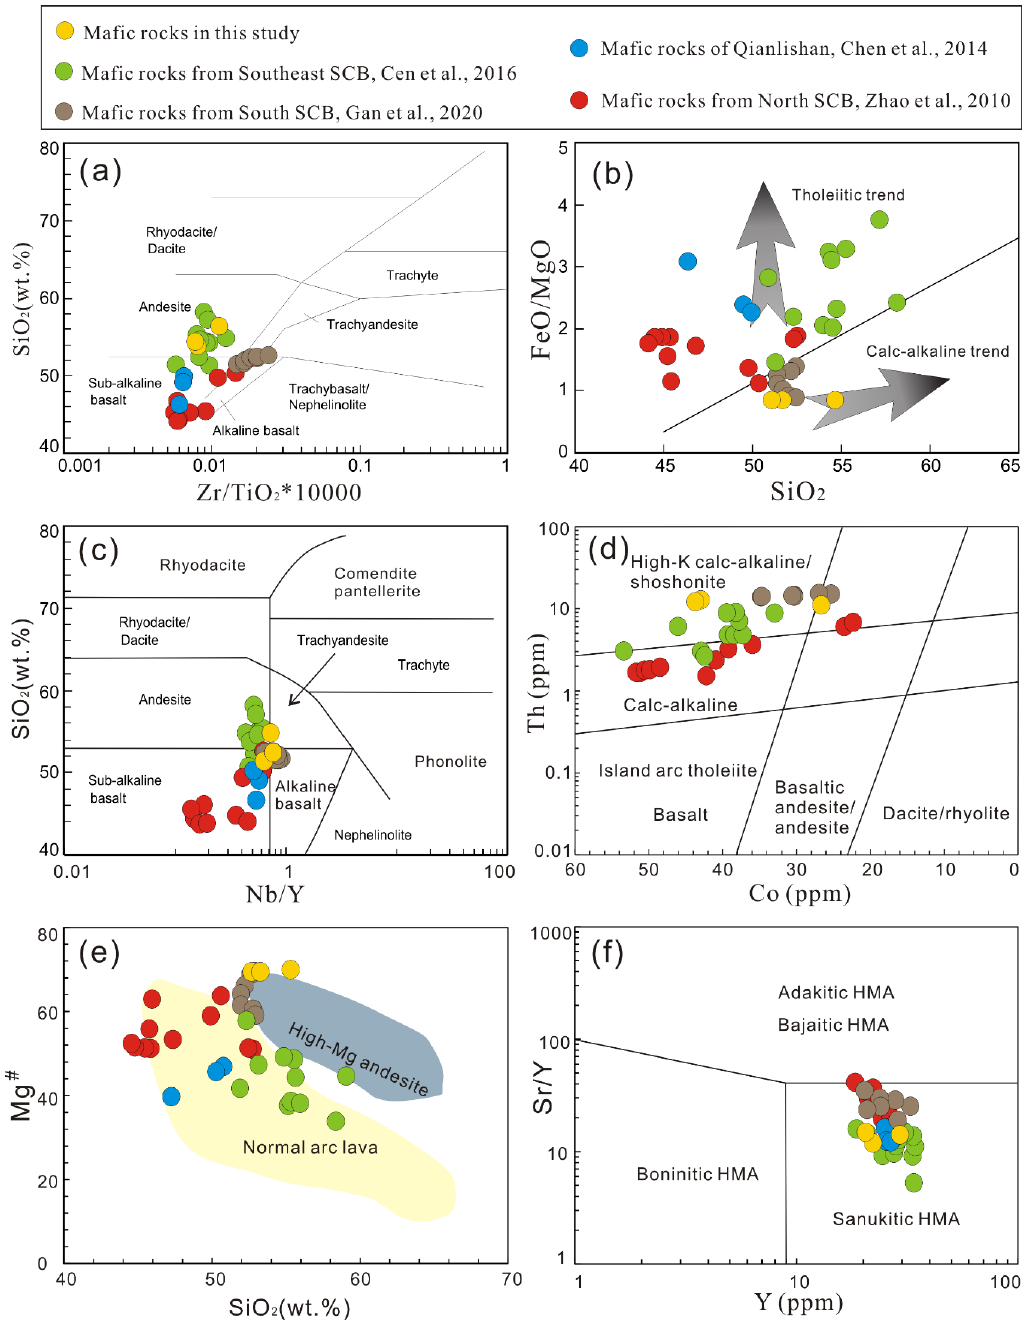
Figure 11. Plots of ( a ) SiO 2 vs. Zr/TiO 2 [74], ( b ) FeO/MgO vs. SiO 2 [71], ( c ) SiO 2 vs. Nb/Y [74], ( d ) Th vs. Co [75], ( e ) Mg# vs. SiO 2 [72], and ( f ) Sr/Y vs. Y [72] for the Qianlishan and the South China Block (SCB) mafic rocks: data for the SCB mafic rocks are from Cen et al. [76], Chen et al. [20], Gan et al. [39], and Zhao et al. [77].